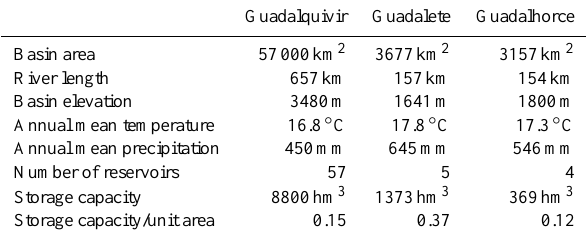
Table 1. Geomorphological and climatic characteristics of the Guadalquivir, Guadalete and Guadalhorce